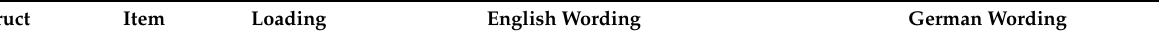
Table A1. Item wording and PLS measurement model